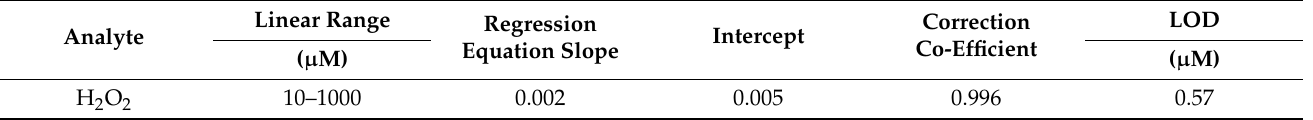
Table 2. Analytical performance of the Colorimetric assay for H 2 O 2 based on Zr-GO enzyme mimic. Linear Range Analyte